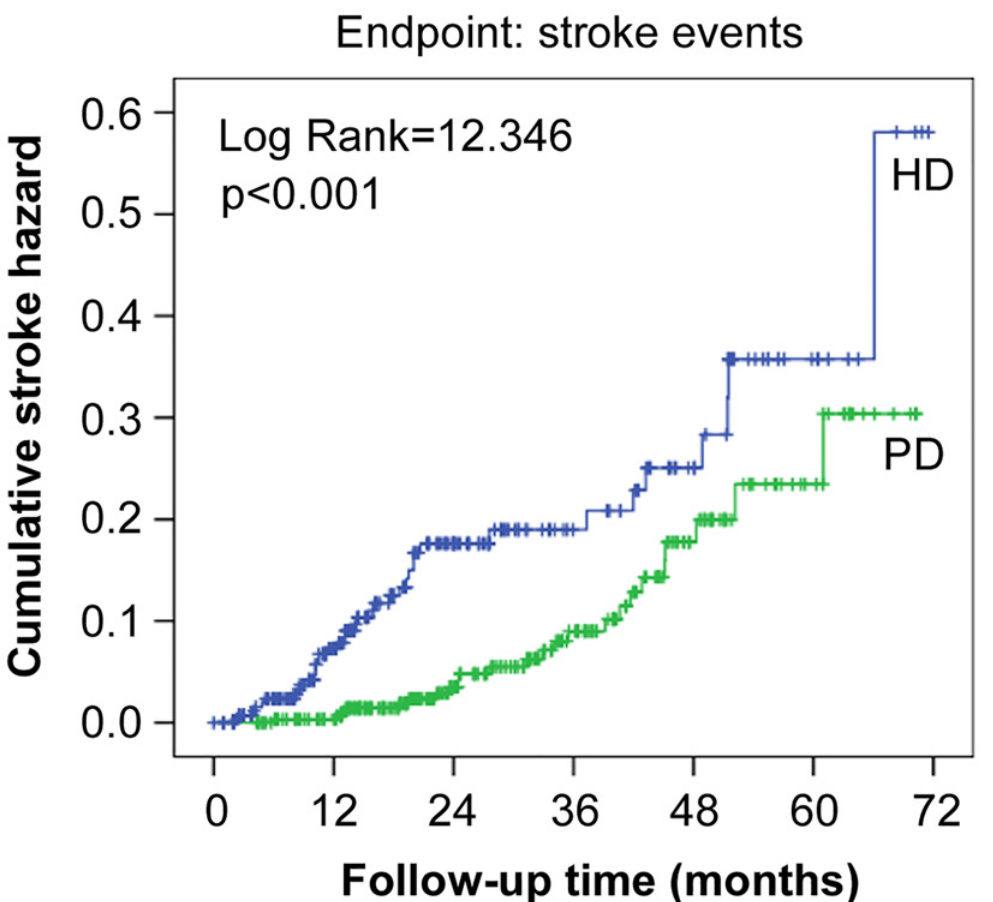
Fig 1. Cumulative hazard of stroke events in hemodialysis and peritoneal dialysis groups. The hazard ratio in the hemodialysis group compared to the peritoneal dialysis group was 2.43 (95% confidence interval, 1.45 – 4.06). HD, hemodialysis; PD, peritoneal dialysis.